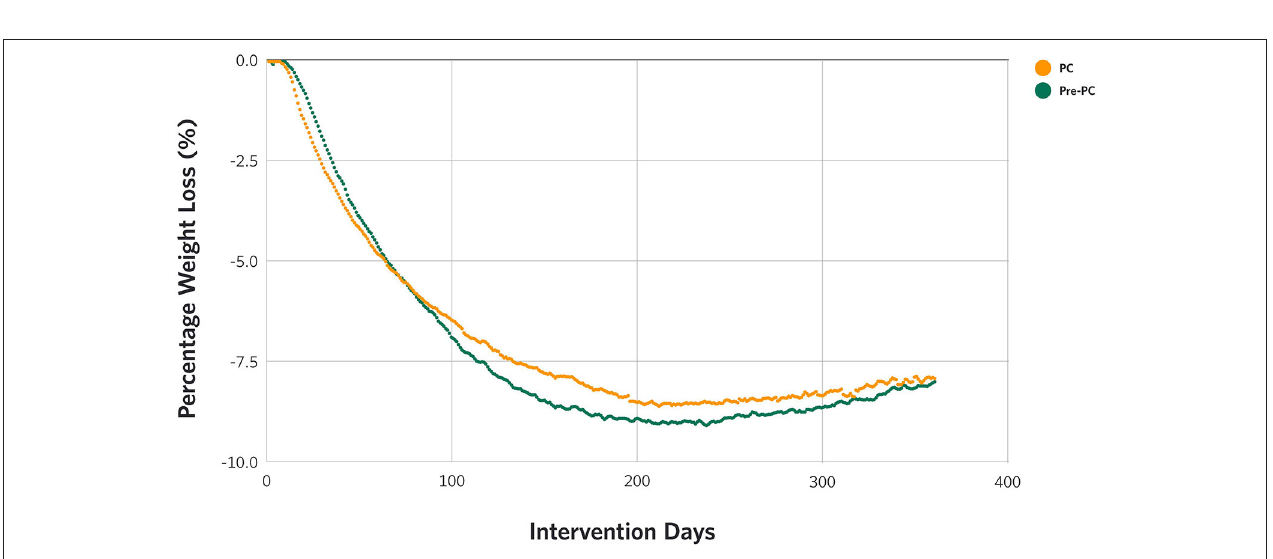
FIGURE 2 | Percentage weight loss (%) trend during 1 year of the intervention in Pre-PC and